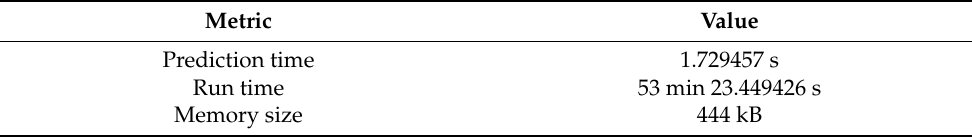
Other metrics recorded (multinomial classification) for the deep ANN-based anomaly detector.